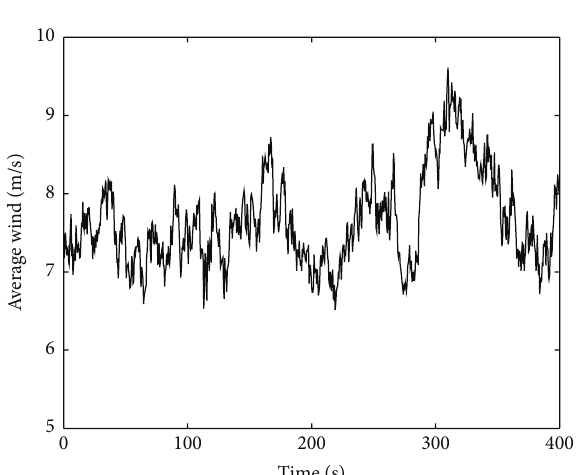
Figure 6: Average wind in 400 seconds.